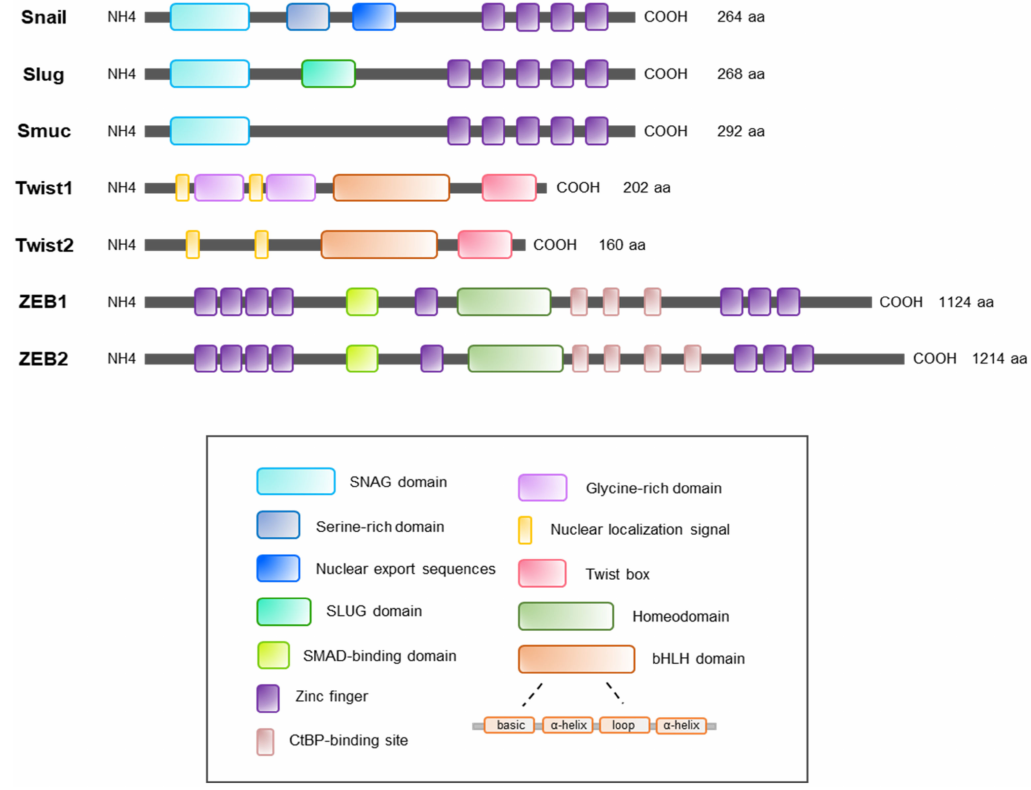
Figure 3. A schematic representation of structures of EMT-TFs. The Snail family (Snail, Slug, and Smuc) commonly includes the SNAG domain in the N-terminal and the zinc finger domain in the C-terminal. Snail contains the nuclear export sequences and serine-rich domain that control the stability of the Snail. The SNAG domain is however only present in Slug. The latest recognized member in Snail family, Smuc does not have both serine-rich domain and SNAG domain. The Twist family (Twist1 and Twist2) mainly consists of a bHLH domain and a Twist box in C-terminal for its transcriptional activity. However, glycine rich domains are only present in Twist1. The bHLH domain consists of basic amino acids followed by two alpha helices, which is separated by a loop of different length. The ZEB family (ZEB1 and ZEB2) has the largest protein size compared to other EMT-TFs. This ZEB family contains various regulatory domains, which include clusters of zinc fingers in N-terminal and C-terminal, homeodomain, SMAD-binding domain, and CtBP-binding site. CtBP, C-terminal binding